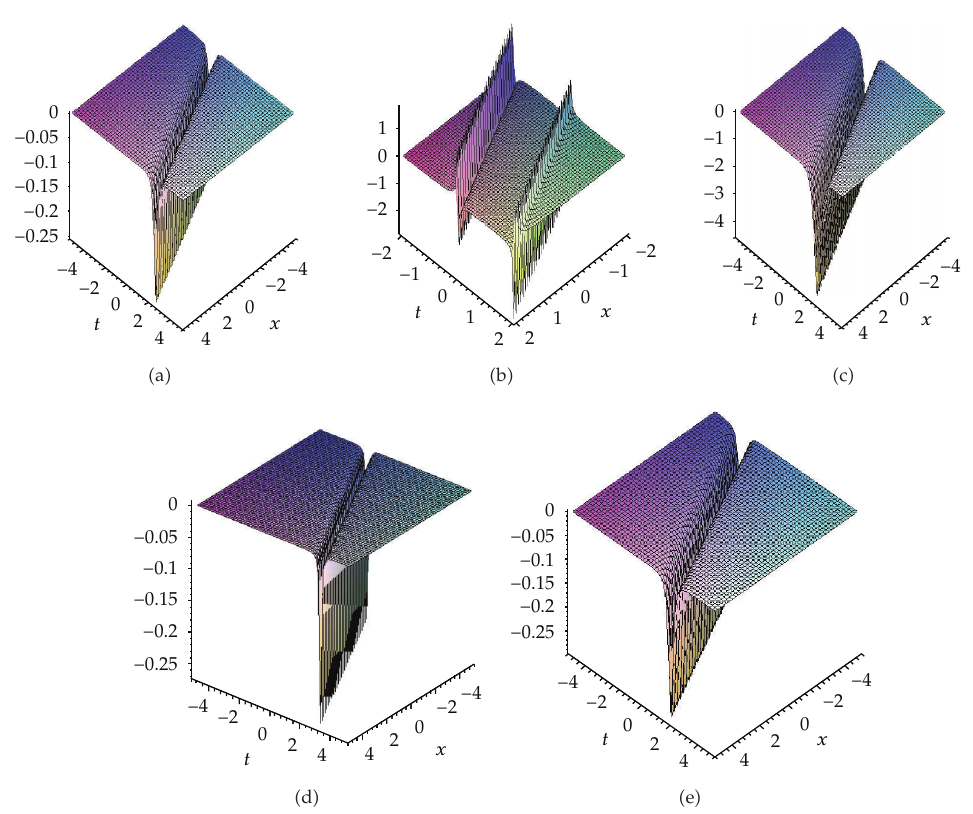
Figure 1: Evolutional behaviour of u 1 describes dark soliton: (cid:3) a (cid:4) p (cid:7) q (cid:7) 1; (cid:3) b (cid:4) p (cid:7) 1 / 32 , q (cid:7) 1 / 33 , (cid:3) singular wave solution (cid:4) ; (cid:3) c (cid:4) p (cid:7) 23 , q (cid:7) 32; (cid:3) d (cid:4) p (cid:7) 1 / 13 , q (cid:7) 11; (cid:3) e (cid:4) p (cid:7) 13 , q (cid:7) 1 / 11 .